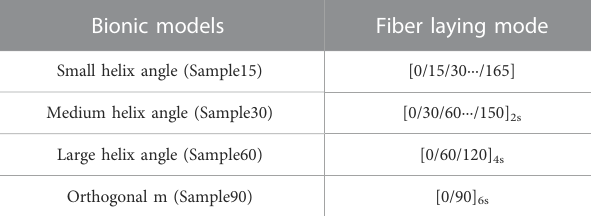
TABLE 1 Models of multilayer fi ber biomimetic composites. Bionic models